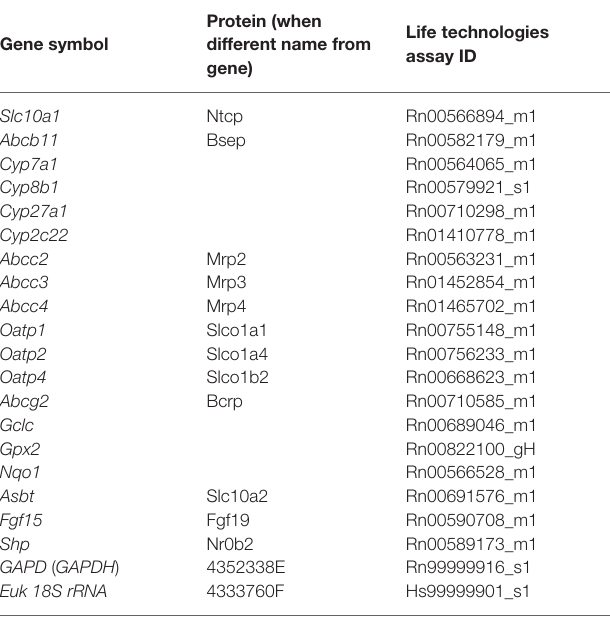
TABLE 1 | Pre-designed TaqMan ® Gene Expression Assay kits (Life Technologies) used for quantitative reverse transcription-PCR (qRT-PCR). Protein (when Gene symbol different name from